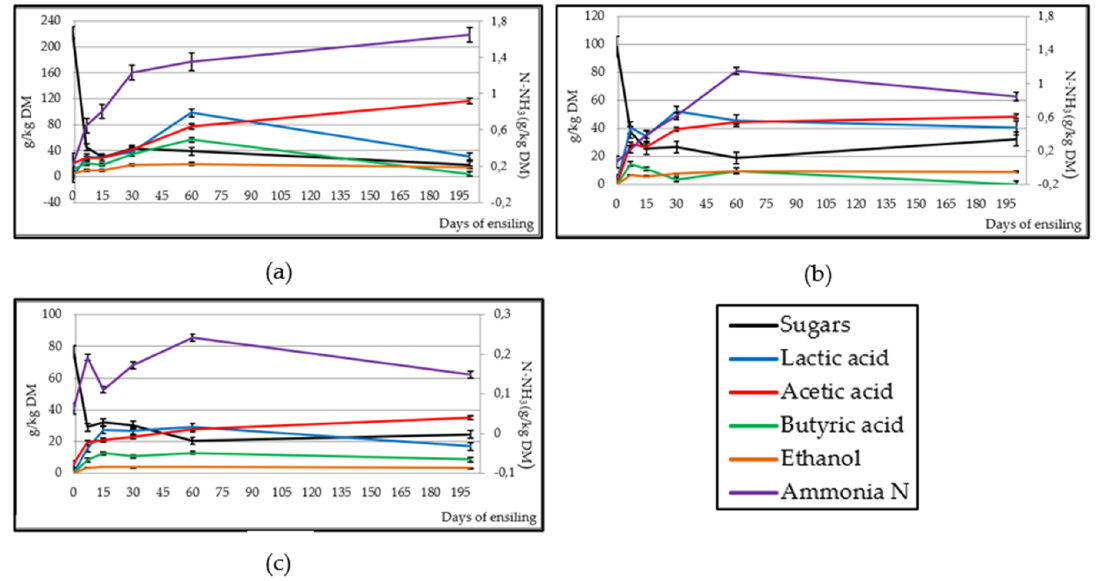
Figure 4. Effect of ensiling on sugar content and fermentative components in broccoli by-product ( a ), artichoke by-product ( b ) and artichoke plant stubble ( c ) silages. Table 2. Phytosanitary residues (mg/kg) in silages after 200 days of ensiling in round bales broccoli by-product (BB), artichoke by-product (AB) and artichoke plant stubble (APS) silages. Phytosanitary Type BB AB APS MRL Legislation Triadimefon Fungicide Cypermethrin Insecticide n.d. n.d. 0.240 2.00 UE 520 / 2011 MRL: Maximum Residue Limit; n.d.: Not Detected. Chlorpyrifos Insecticide n.d. Miclobutanil Fungicide n.d.